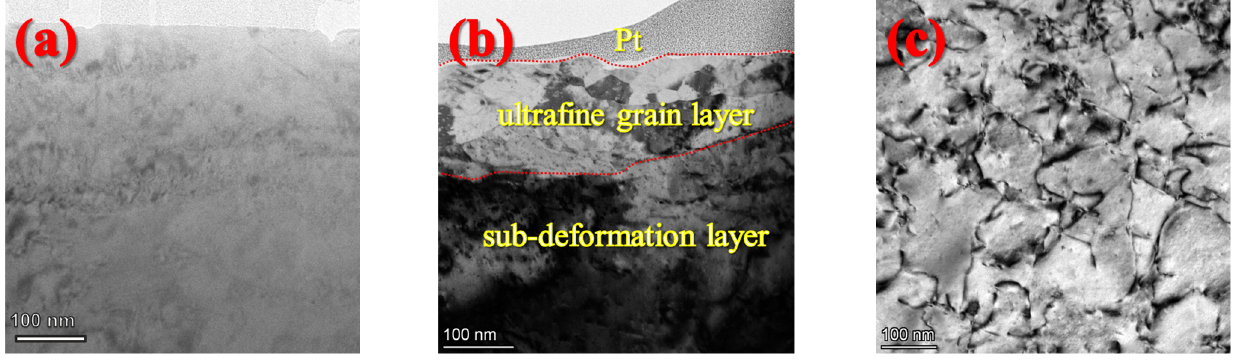
Figure 1. Cross-section TEM observation of the surface layer in UT ( a ) and WJCP-treated ( b , c ) 600 MA. ( b ) Surface ultrafine grain layer, ( c ) sub-surface dislocation structure.